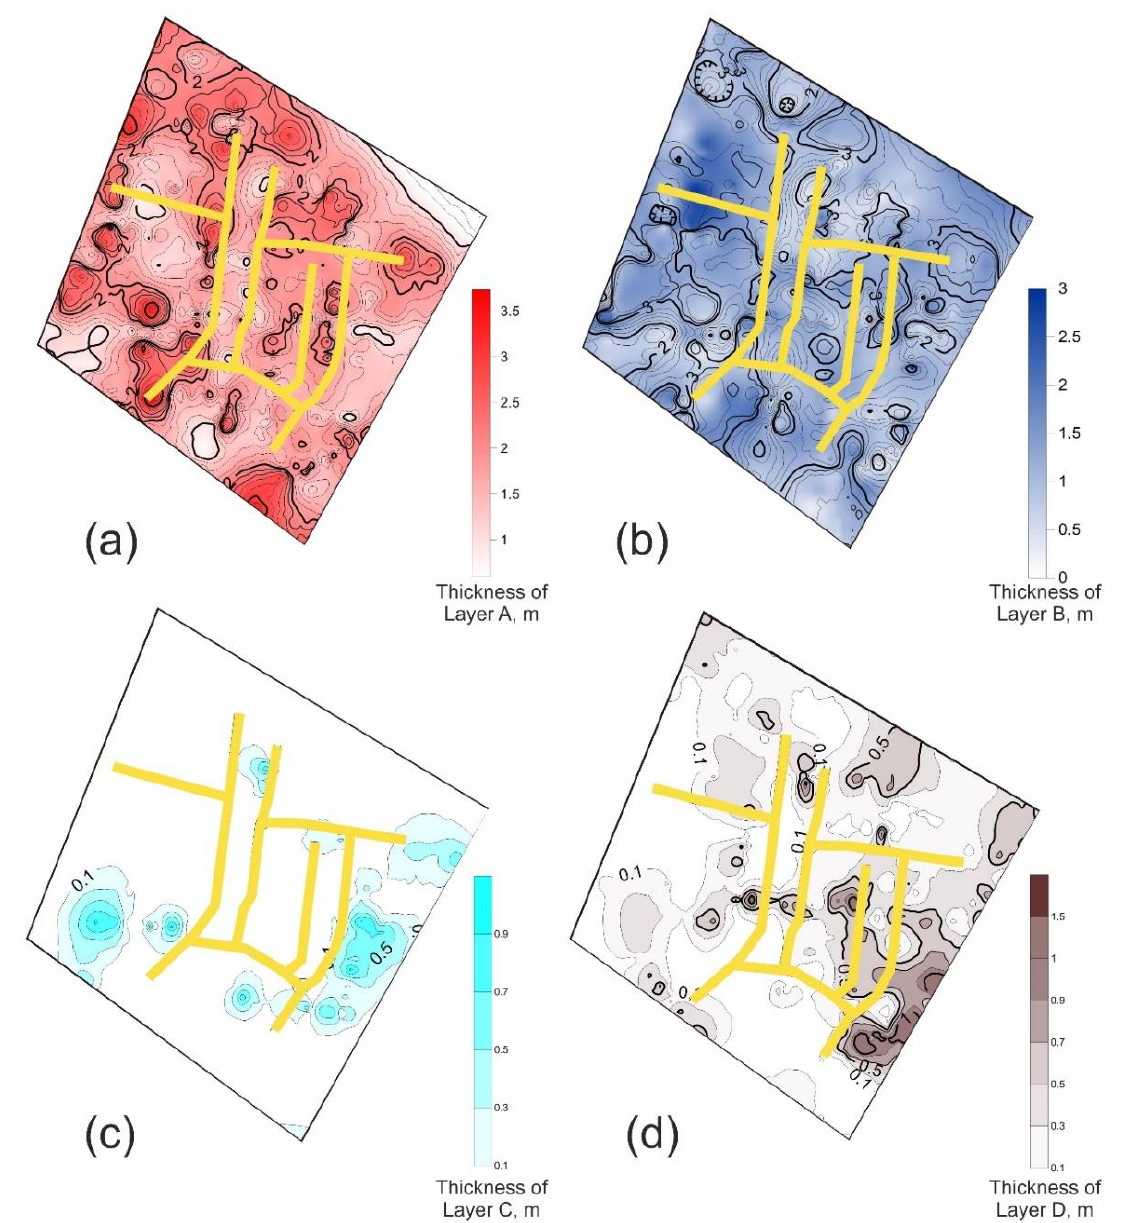
Figure 5. Spatial patterns of near-surface layers: ( a ) thickness of Layer A; ( b ) the bottom (isochores) and thickness (filling) of Layer B; ( c ) thickness of Layer E; ( d ) thickness of Layer F. Yellow lines show the network of streets.